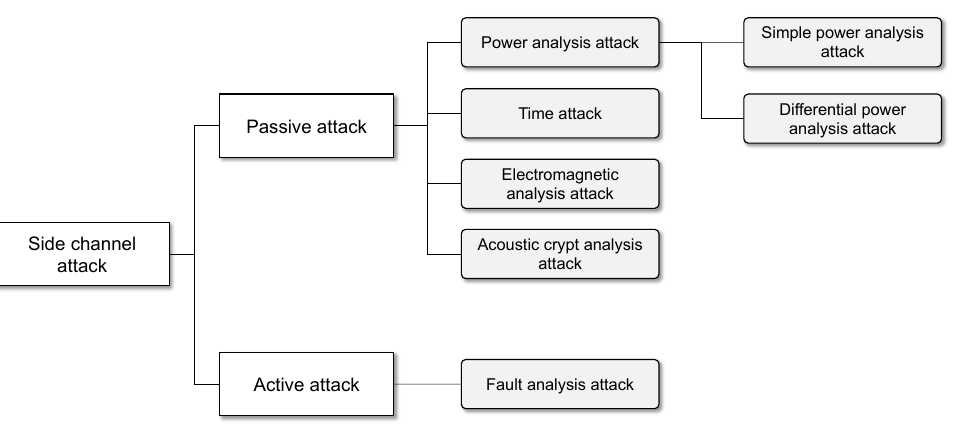
Figure 1. Classification of side-channel attack